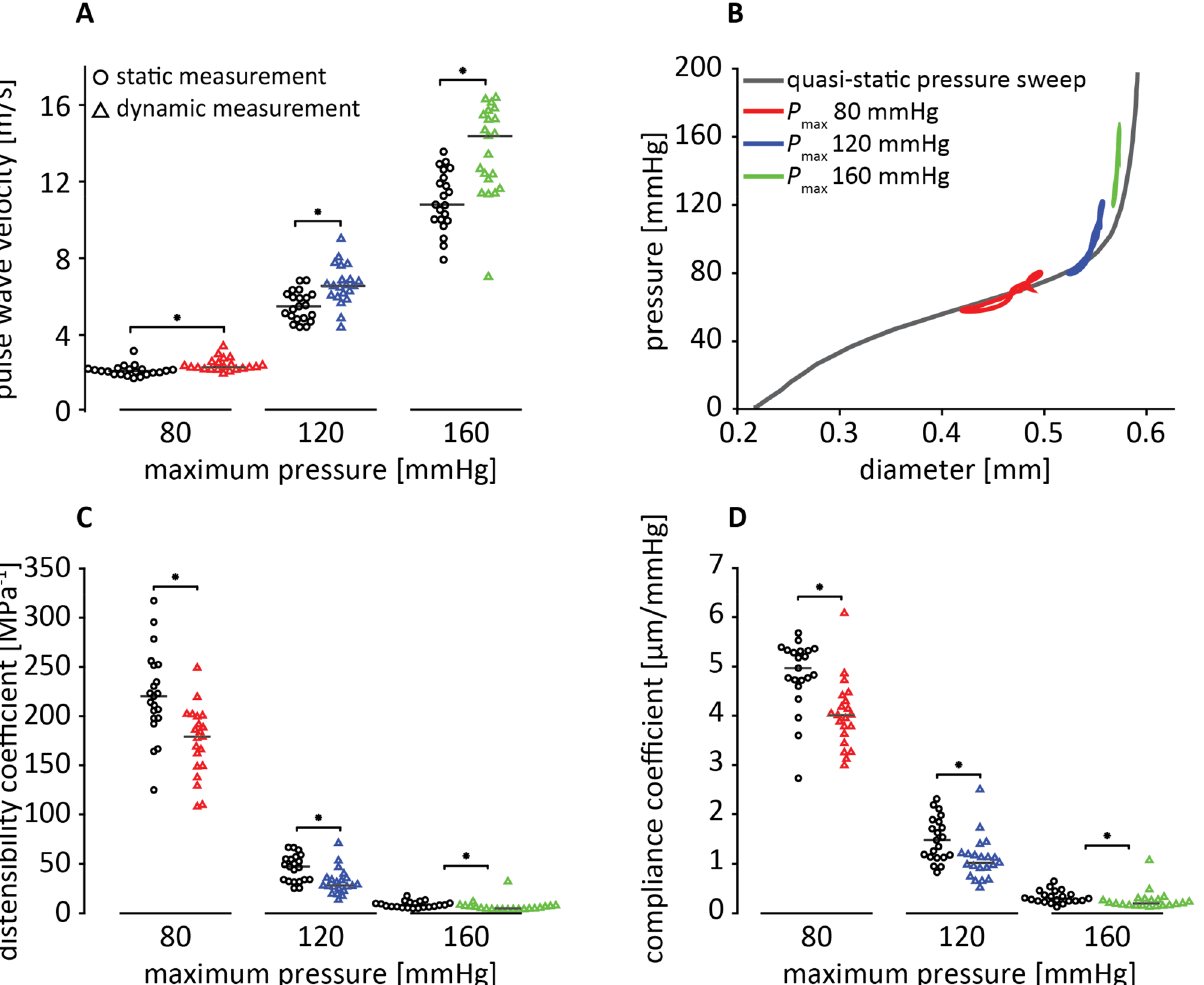
Figure 5. Static experiments underestimate stiffness determined under pulsatile (in vivo) conditions. ( A ) PWV determined from dynamic pressure-diameter curves compared to the corresponding quasi-static pressure- diameter curve. ( B ) Representative set of quasi-static (grey) and dynamic pressure-diameter curves (the latter obtained for maximum pressures P max of 80, 120, 160 mmHg). ( C ) Distensibility coefficient (DC) determined from dynamic pressure-diameter curves compared to the corresponding quasi-static pressure-diameter curve. ( D ) Compliance coefficient (CC) determined from dynamic pressure-diameter curves compared to the corresponding quasi-static pressure-diameter curve. * p < 0.05, n =